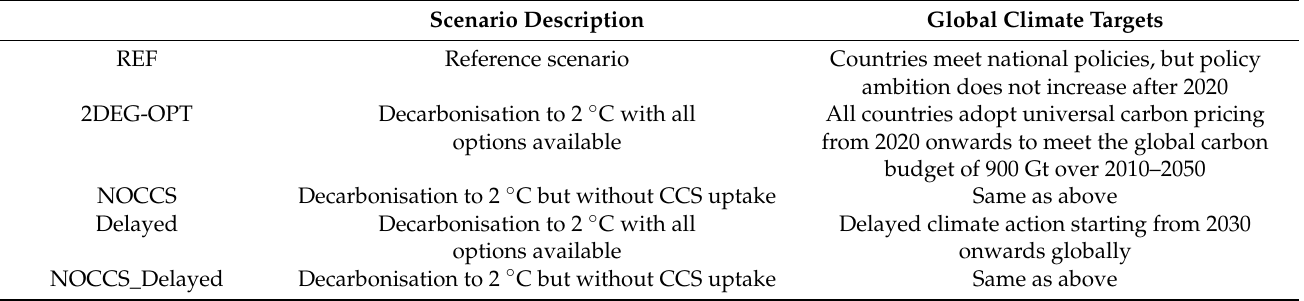
Table 2. Scenario